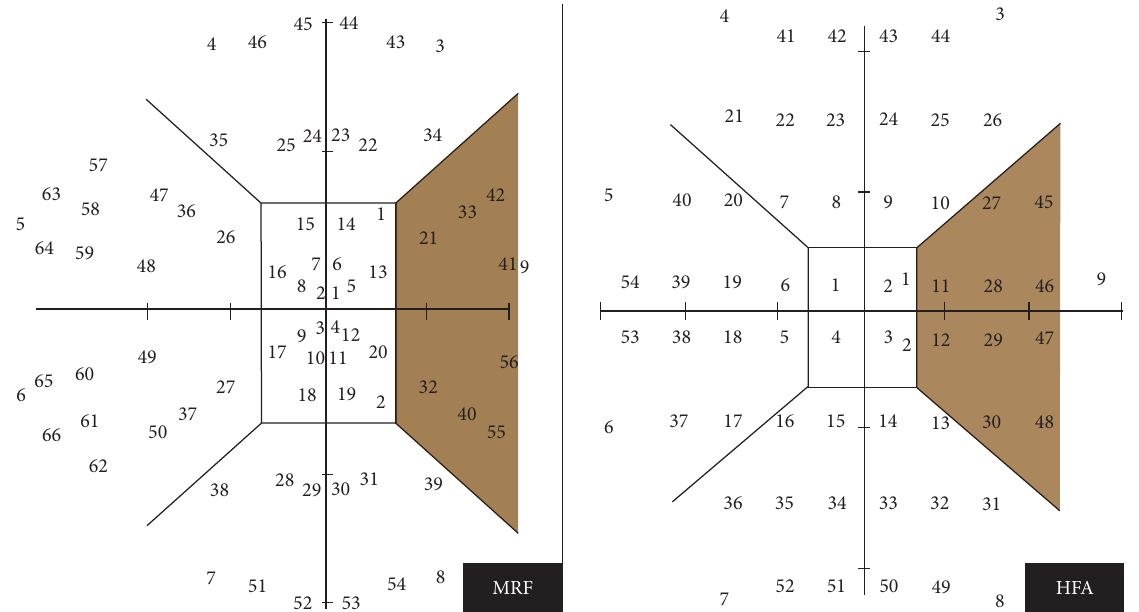
Figure 1: Nine zones with 66 test spots for the Melbourne Rapid Fields (MRF) full test and 54 test spots for the Humphrey Field Analyzer (HFA) 24-2 grid.